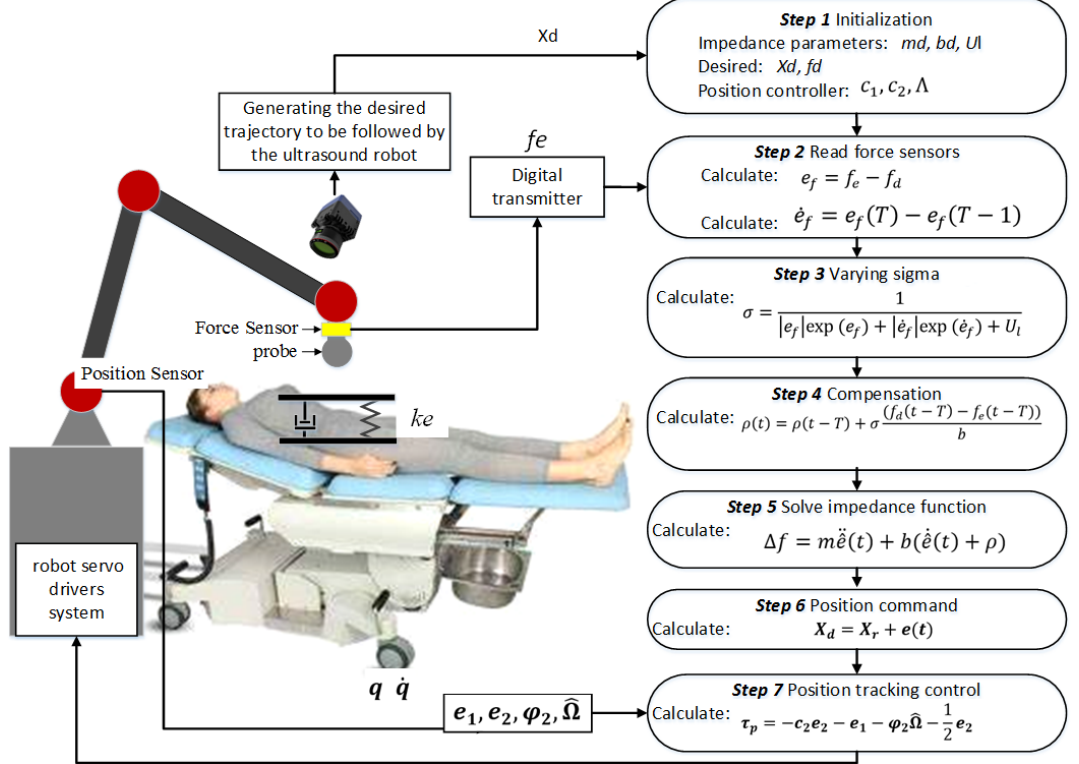
Figure 3. Framework of robot-assisted ultrasonic examination system and the algorithm process.